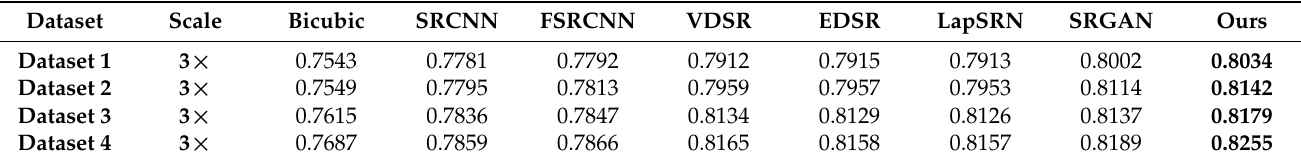
Table 3. Average SSIM on Dataset1, Dataset2, Dataset3 and Dataset4 with different algorithms.